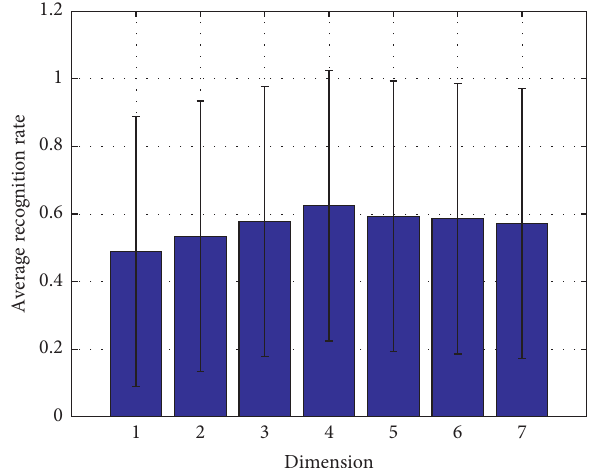
Figure 3: Relationship between average recognition rate and